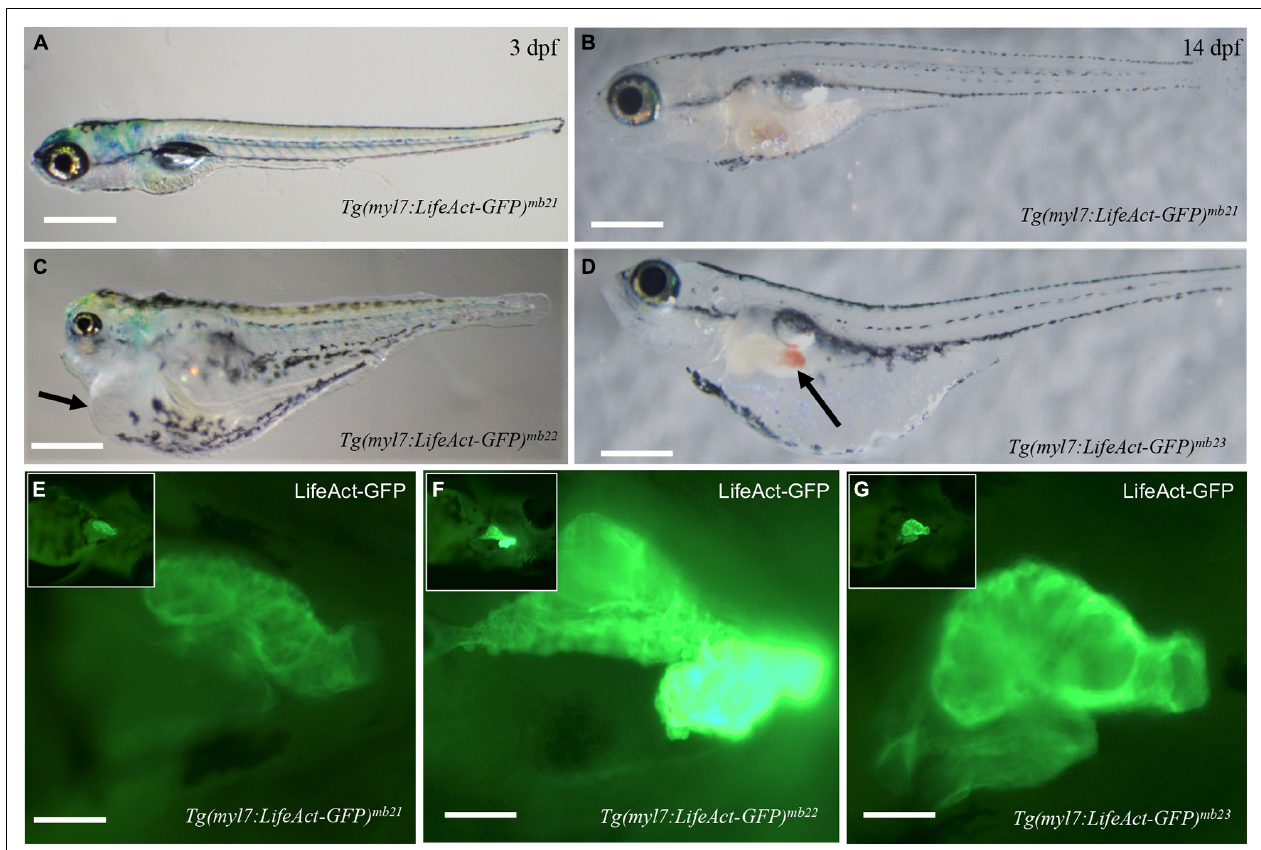
FIGURE 2 | Development of pericardial edema in Tg(myl7:Lifeact-GFP) mb 22 and Tg(myl7:Lifeact-GFP) mb 23 transgenic embryos. (A–D) Morphology of representative transgenic embryos from Tg(myl7:Lifeact-GFP) mb 21 line with no edema (A,B) , and Tg(myl7:Lifeact-GFP) mb 22 (C) , and Tg(myl7:Lifeact-GFP) mb 23 (D) transgenic lines with edema phenotypes at 3 (C) and 14 dpf (D) , respectively. Pericardial edema is indicated by arrows in Tg(myl7:Lifeact-GFP) mb 22 (C) , and Tg(myl7:Lifeact-GFP) mb 23 (D) transgenic larvae. Scale bars: 500 µ m. (E–G) Lifeact-GFP expression in the hearts of Tg(myl7:Lifeact-GFP) mb 21 (E)